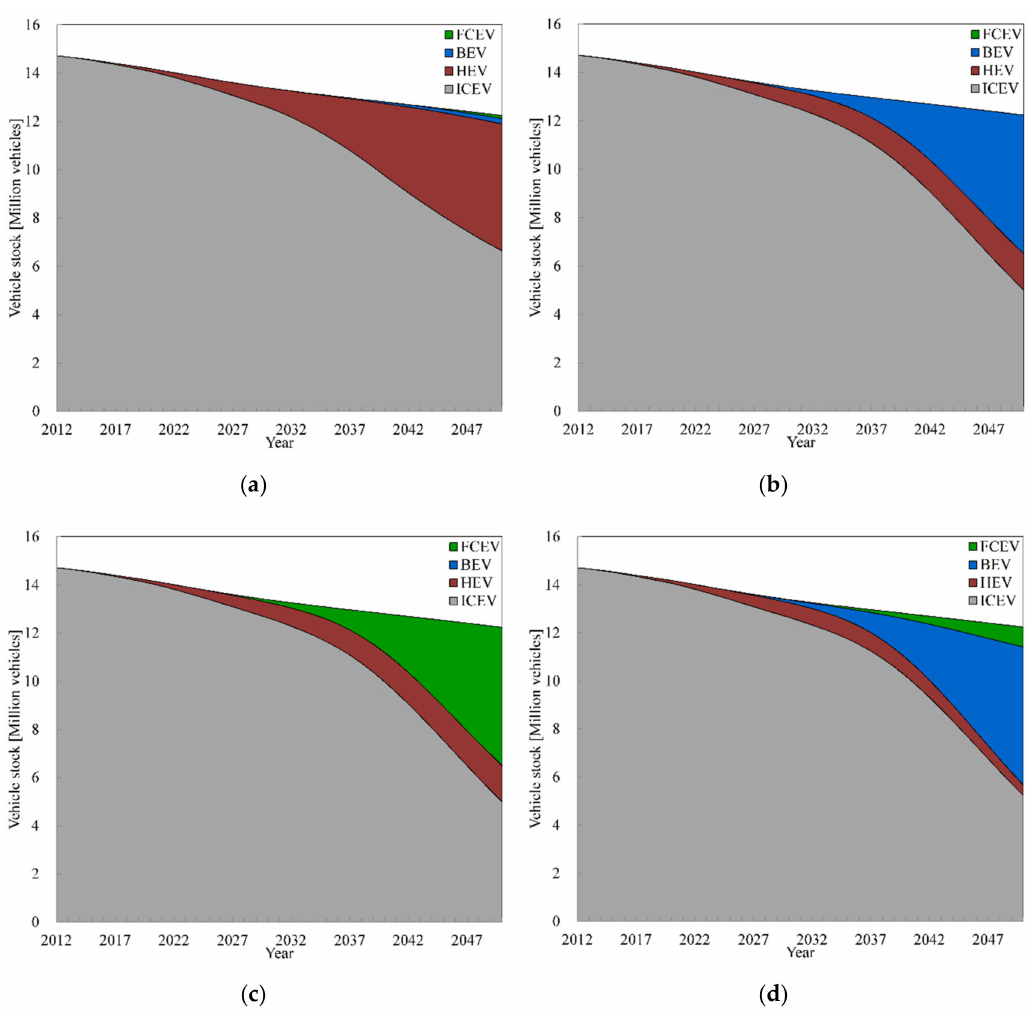
Figure 9. Road freight vehicle fleet stock: ( a ) Base scenario; ( b ) HBB scenario; ( c ) HFF scenario; and ( d ) FBB